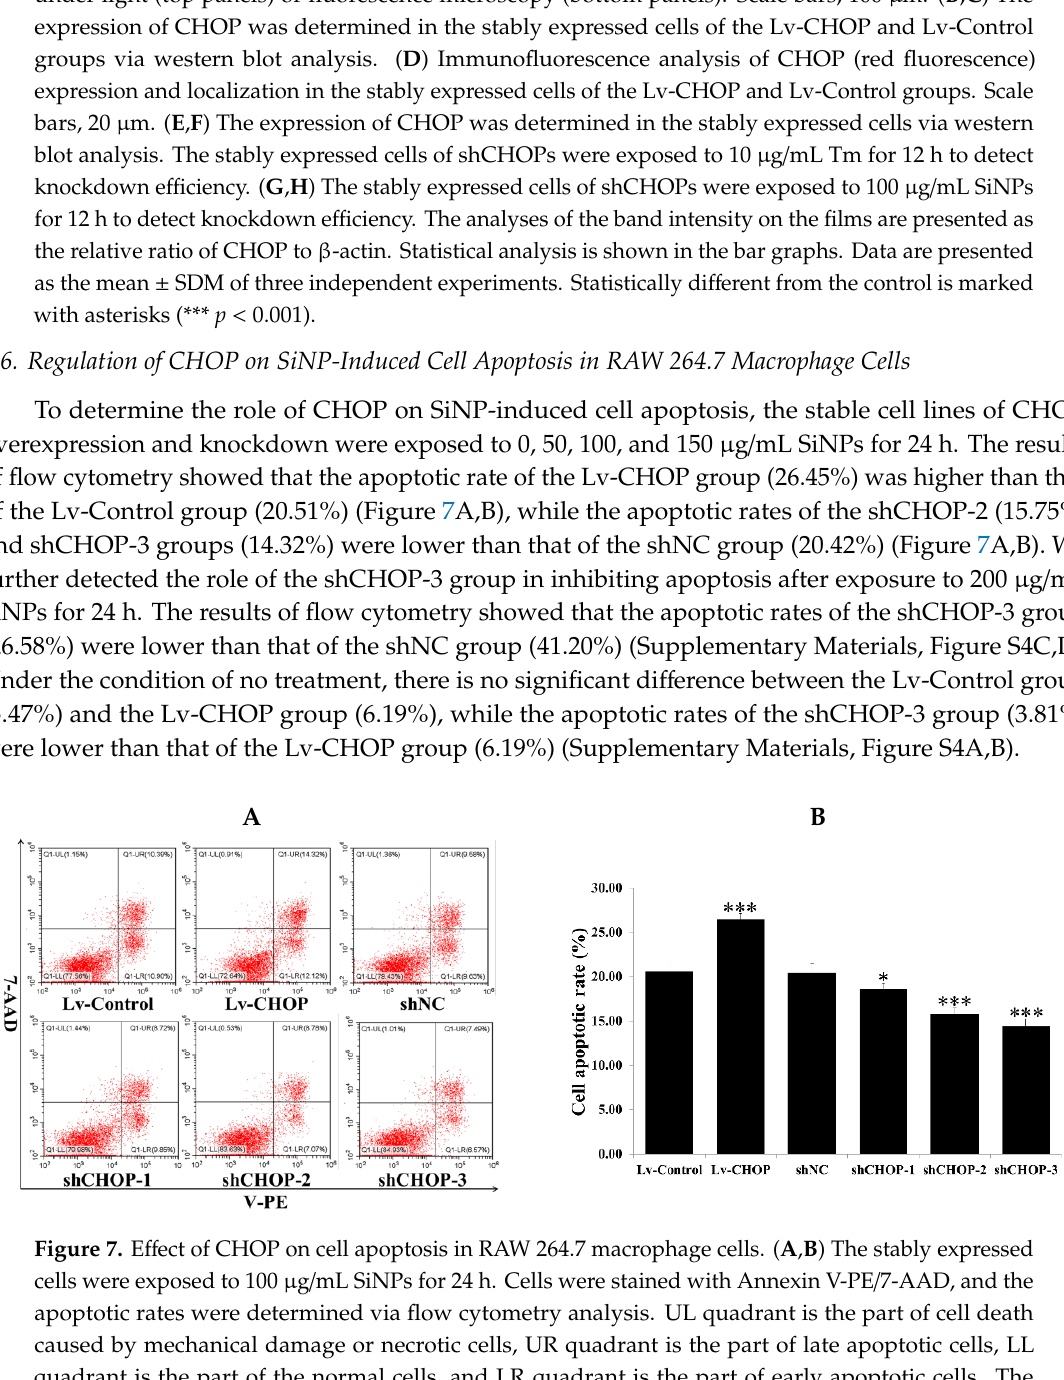
cytometry. Fluorescence images of the stably expressed cells of the Lv-CHOP ( a ), Lv-Control ( b ), shCHOP-1 ( c ), shCHOP-2 ( d ), shCHOP-3 ( e ), and shNC ( f ) groups; EGFP expression was observed under light (top panels) or fluorescence microscopy (bottom panels). Scale bars, 100 µ m. ( B , C ) The expression of CHOP was determined in the stably expressed cells of the Lv-CHOP and Lv-Control groups via western blot analysis. ( D ) Immunofluorescence analysis of CHOP (red fluorescence) expression and localization in the stably expressed cells of the Lv-CHOP and Lv-Control groups. Scale bars, 20 µ m. ( E , F ) The expression of CHOP was determined in the stably expressed cells via western blot analysis. The stably expressed cells of shCHOPs were exposed to 10 µ g / mL Tm for 12 h to detect for 12 h to detect knockdown e ffi ciency. The analyses of the band intensity on the films are presented as the relative ratio of CHOP to β -actin. Statistical analysis is shown in the bar graphs. Data are presented as the mean ± SDM of three independent experiments. Statistically di ff erent from the control is marked with asterisks (*** p < 0.001).